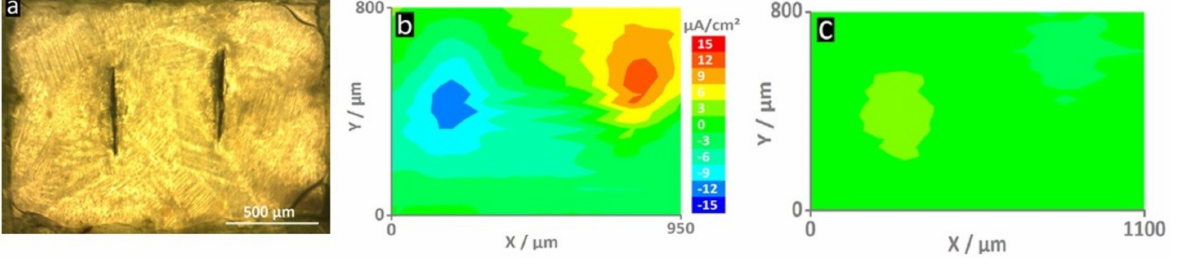
Figure 10. These optical micrographs ( a ) show the self-healing surface with two vertical screwdriver- blade indentations that form the defects through the coating. The map of the reference sample ( b ) shows high current densities ( ± 12 µ A/cm 2 )—an indication of an actively corroding sample. On the contrary, the sample with MLDH ( c ) shows much smaller current densities and thus corrosion inhibition